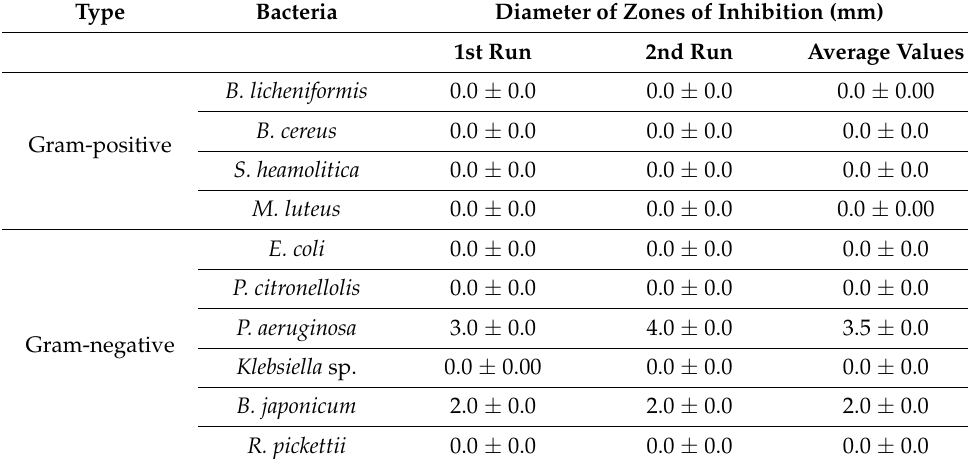
Table 2. Antimicrobial effect of olive leaf extract (OLE) using cup plate experiments. Values stand for the diameter (in mm) of zones of